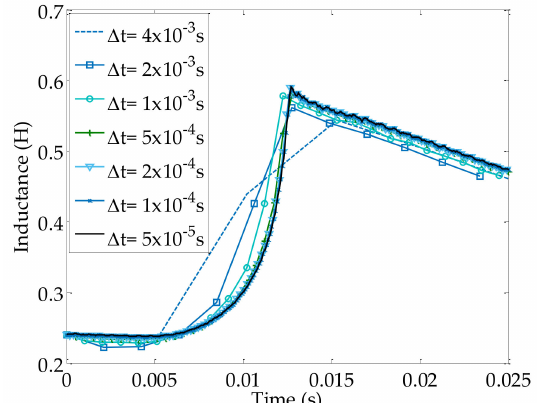
Figure A1. A convergence study of the effect of the time step size on the finite difference scheme proposed in Equation (9). The coil inductance was calculated from the measured coil current in the case when the valve was energized in atmosphere under 23.5